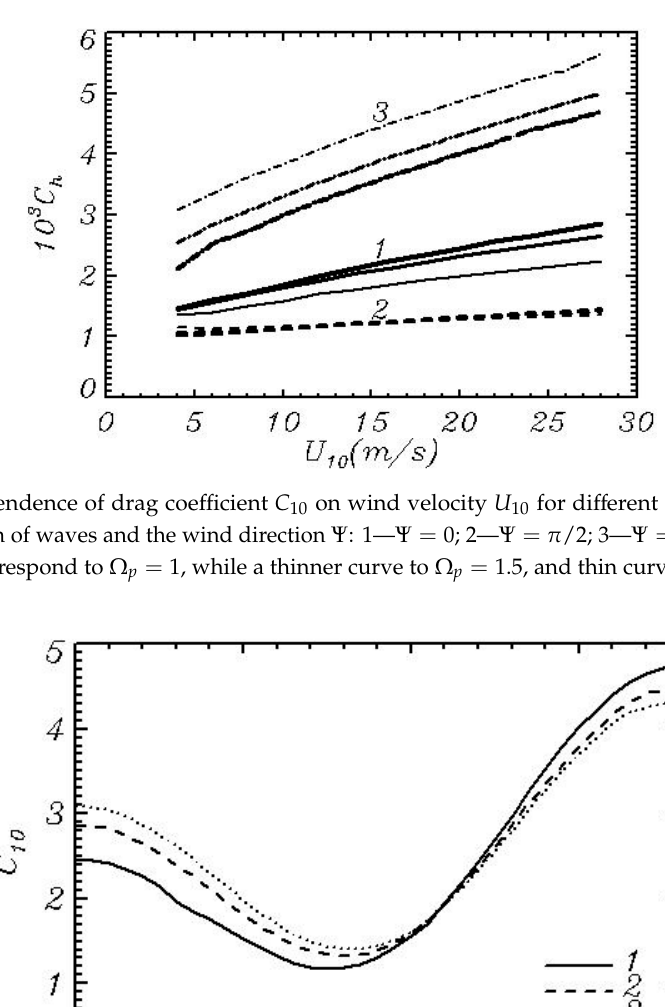
Figure 16. Dependence of drag coe ffi cient C D on the angle between wind direction and general direction Figure 16. Dependence of drag coefficient D C on the angle between wind direction and general of waves for U 10 = 20 m / s : 1— Ω p = 1; 2— Ω p = 1.5; 3— Ω p = direction of waves for 10 Figure 16. Dependence of drag coefficient D C on the angle between wind direction and general direction of waves for 10